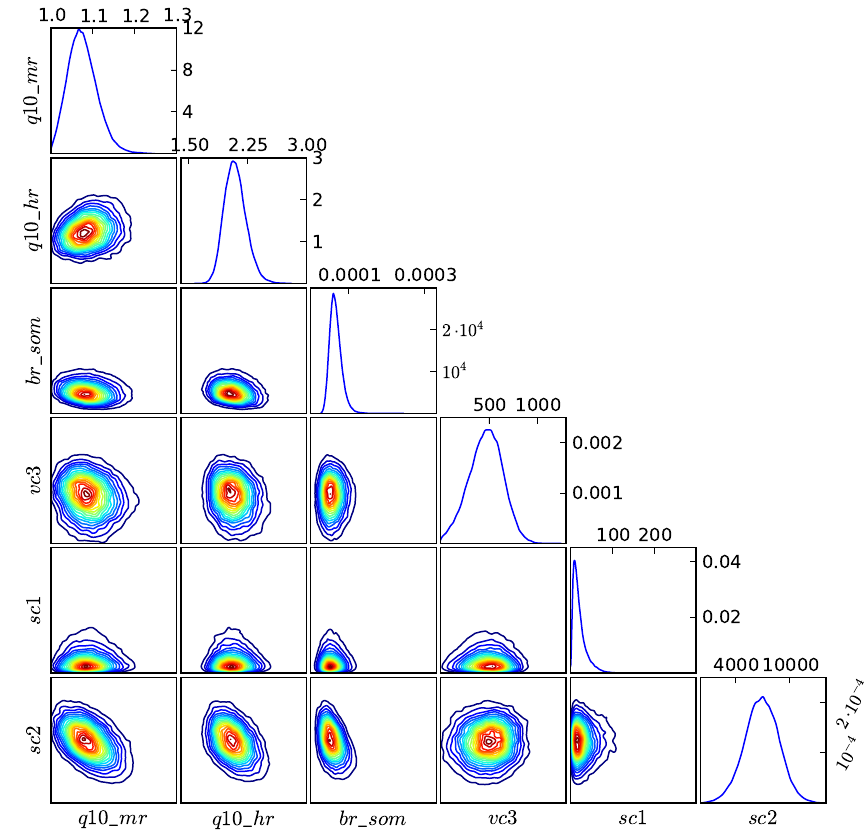
Figure 15. D TR problem: 1-D marginal and 2-D joint marginal PDFs for select parameters correlated with the carbon pools. Marginal PDFs are estimated via KDE based on approximately 4 × 10 5 MCMC samples.